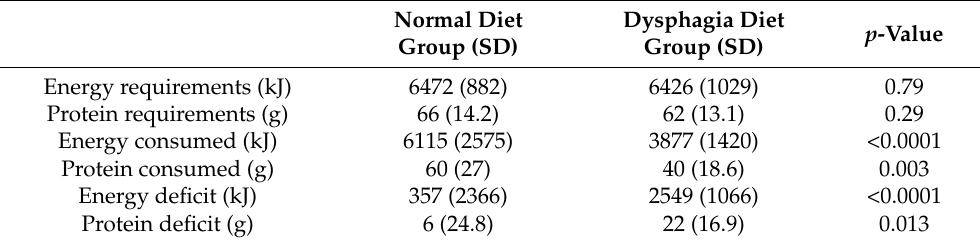
Table 1. Energy and protein requirements and intake